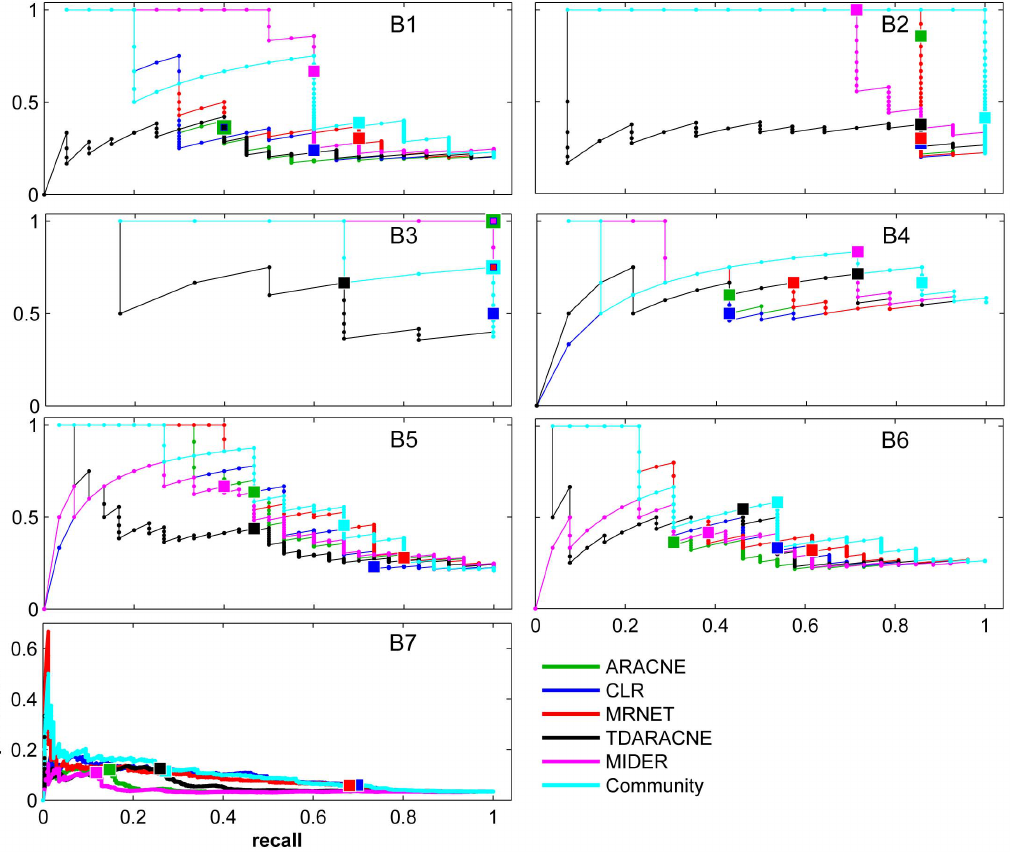
Figure 3. Precision-Recall curves. PR curves (recall in horizontal axis, precision in vertical axis) of all the benchmarks (B1–B7) for five network inference methods (ARACNE, CLR, MRNET, TDARACNE, and MIDER) and for the community prediction. Solid lines and small dots correspond to the (P,R) values obtained by changing the threshold for detecting interactions. Large square points correspond to the (P,R) values obtained with the default (out of the box) settings of each method.